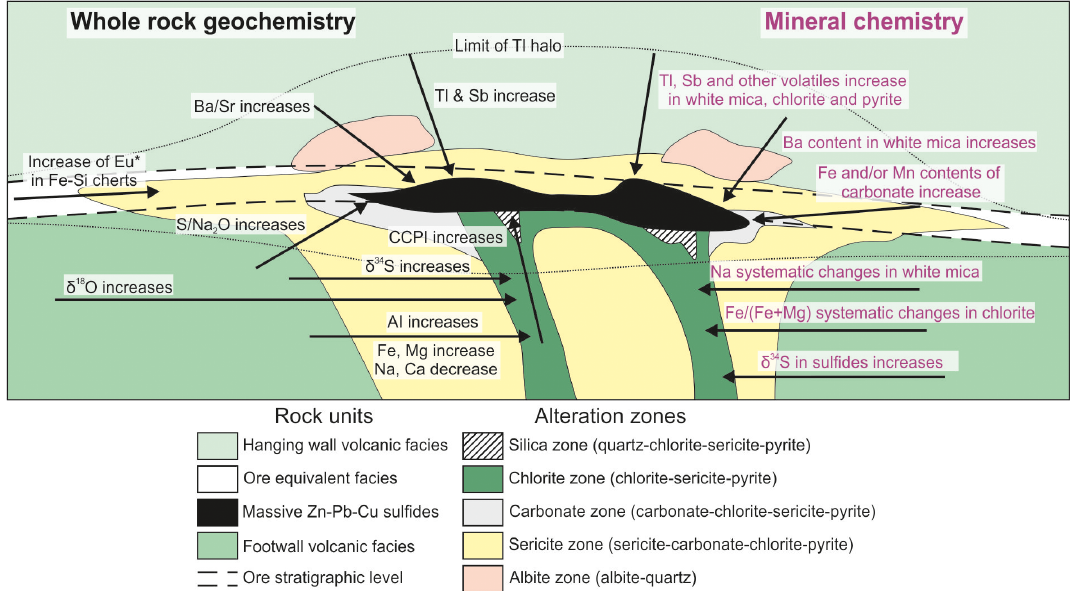
Figure 1. Mineralogical and geochemical halos around VMS deposits. Modified from Large et al. (2001a) with data from Lydon (1988), Cathles (1993), Gale and Fedikow (1999), Lenz and Goodfellow (1993), Goodfellow and Peter (1996), Lentz et al. (1997), Brauhart et al. (2001), Large et al. (2001a, b), Gale (2003), Ames et al. (2016), and Soltani Dehnavi et al. (2018a, b, 2019). AI: alteration index (Ishikawa et al., 1976); CCPI: chlorite–carbonate–pyrite index (Large et al.,